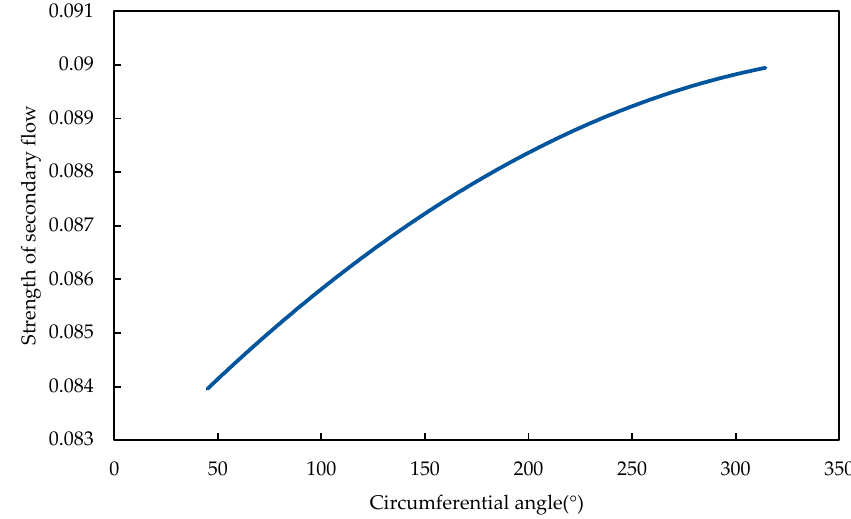
Figure 11. Secondary-flow intensity with circumferential angle.